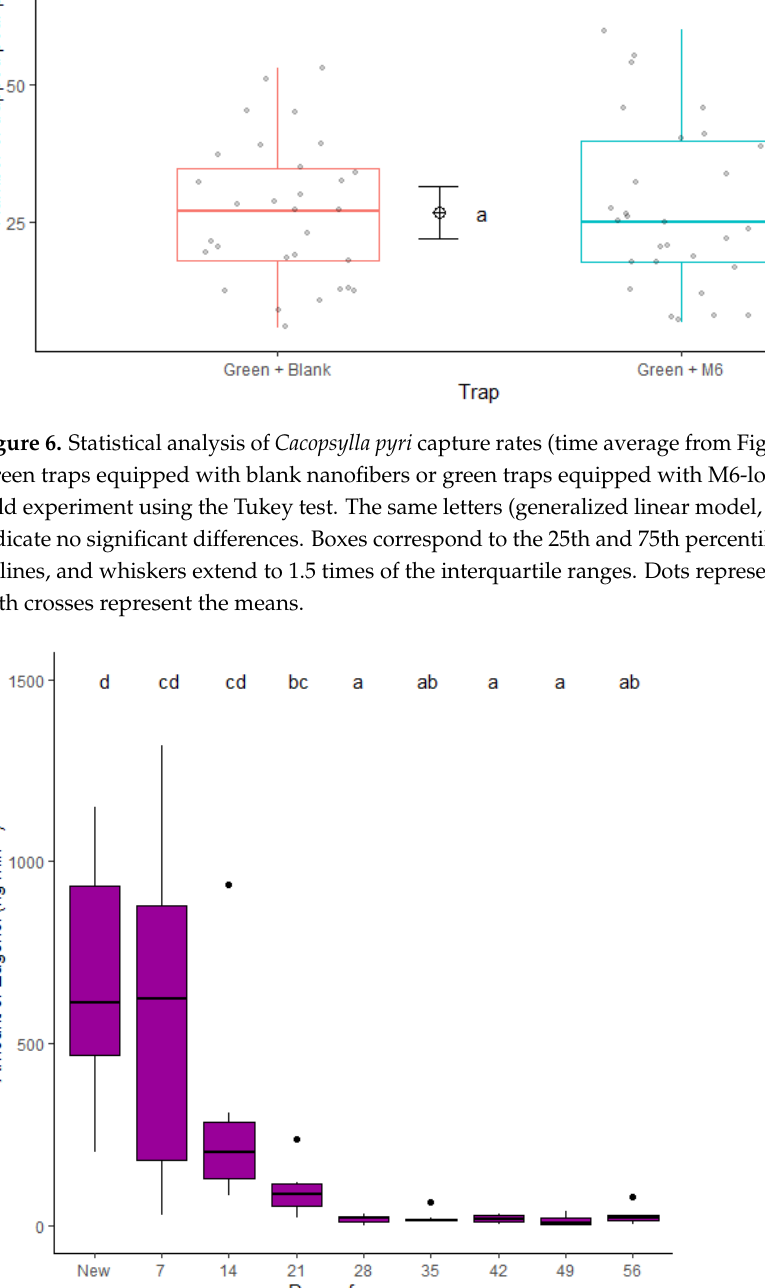
Figure 7. Release rates of eugenol (ng min −1 ) of PCL/CA nanofibers as a function of length of exposure over a period of 56 days. Measurements were performed once a week (n = 6). Different letters (generalized linear model, Tukey test, p < 0.05) indicate significant differences. Boxes correspond to the 25th and 75th percentiles, medians appear as lines, and whiskers extend to 1.5 times of the interquartile ranges. Dots represent outliers.